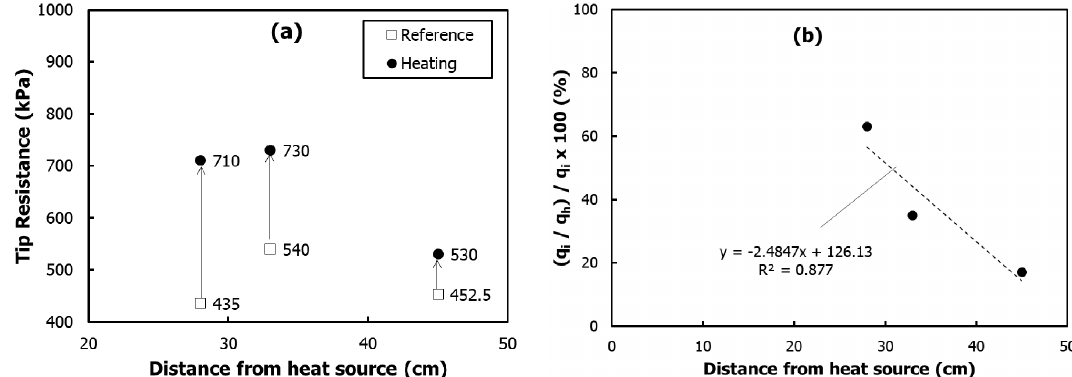
Figure 14. The variation of the tip resistance according to the distance from the surface of the electric heat pipe (Cases 5, 6 and 8), ( a ) the comparison of the variation in tip resistance before and after heating; ( b ) the comparison of the increased rate of tip resistance after heating.